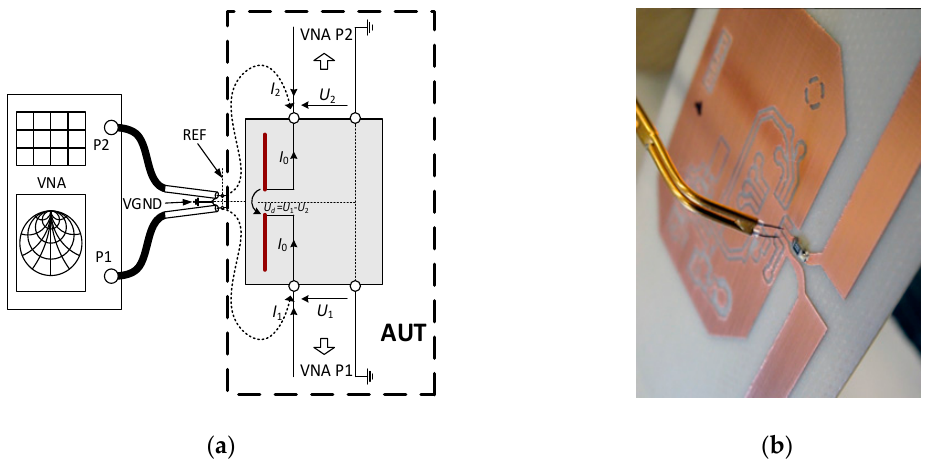
Figure 16. Determination of impedance in RFID antenna: ( a ) Idea of method; ( b ) Attaching probes to antenna under tests.